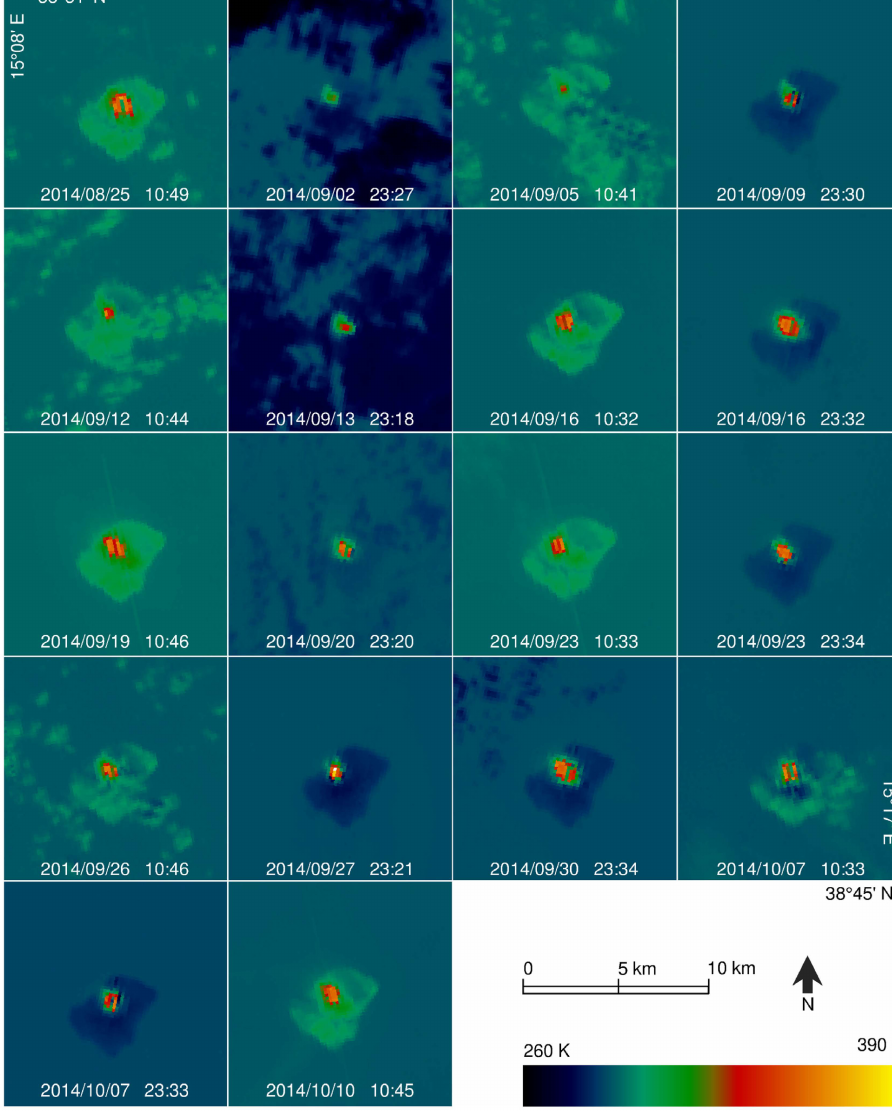
Figure 5. TET-1 MIR temperature corrected for emissivity and atmospheric effects over Stromboli. Lava flows appear in red-orange-yellow colors while the background appears in black-blue-green colors.